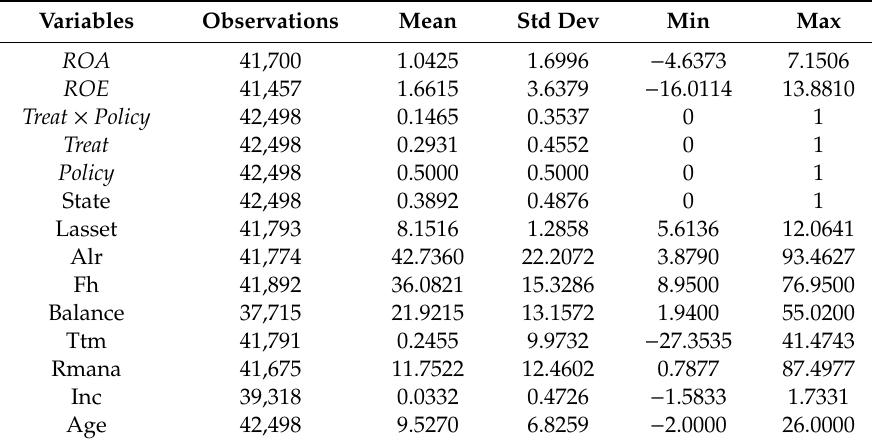
Table 2. Summary statistics of the variables.